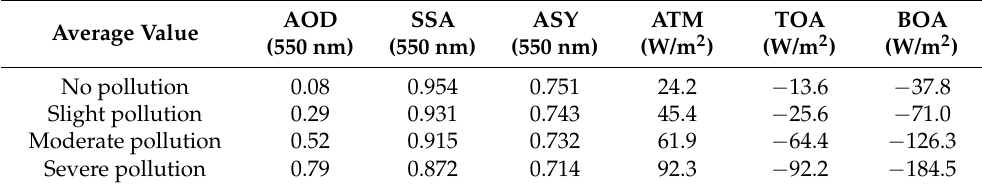
Table 2. The average values of the data at different degrees of pollution.